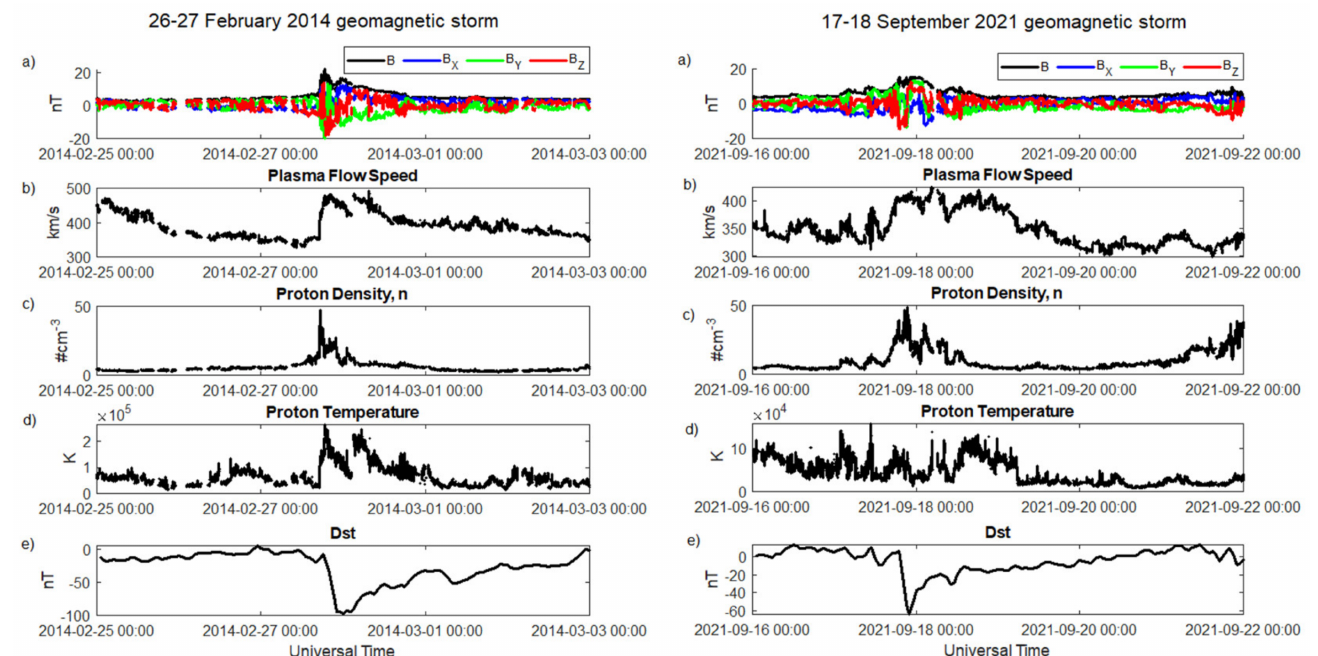
Figure 1. The Space Weather, Interplanetary Magnetic Field parameters and geomagnetic activity during (left) 25 February–2 March 2014 and (right) 16–21 September 2021: ( a ) Interplanetary Magnetic Field components and strength; ( b ) solar wind speed; ( c ) solar wind proton density and ( d ) tem- perature; ( e ) Dst index. Data source: OMNIWeb Data Explorer (NASA) and World Data Center for Geomagnetism